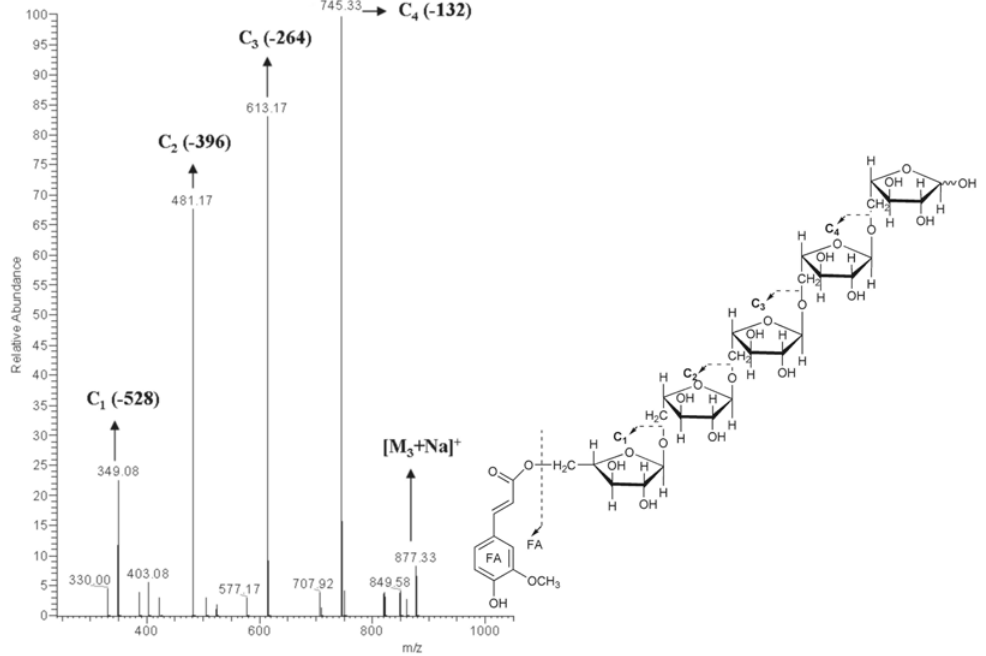
Figure 3. Second order MS of the singly charged parent ion [M arabinopentaose ( 3 )